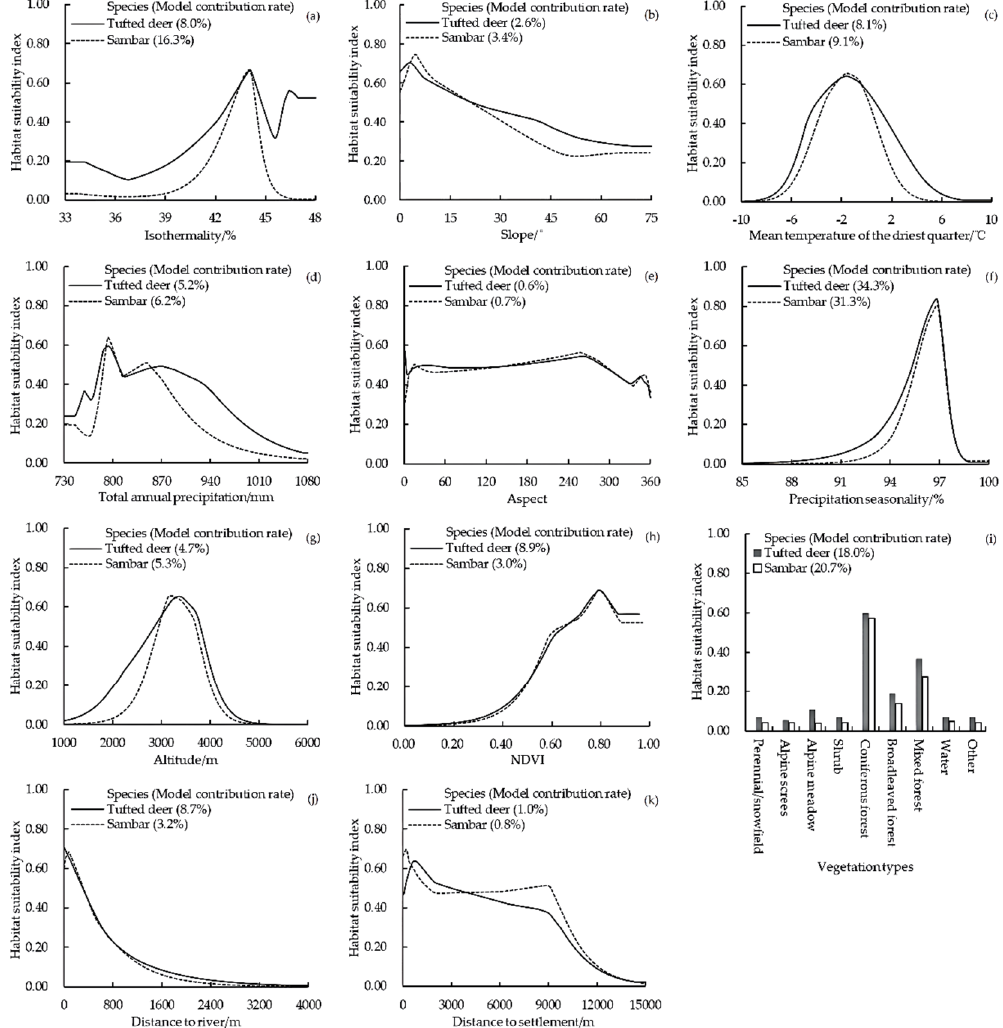
Figure 4. Response curves of habitat suitability index of tufted deer and sambar against the 11 environmental variables ( a – k ), with percent contribution of each variable for each species shown in following parentheses.